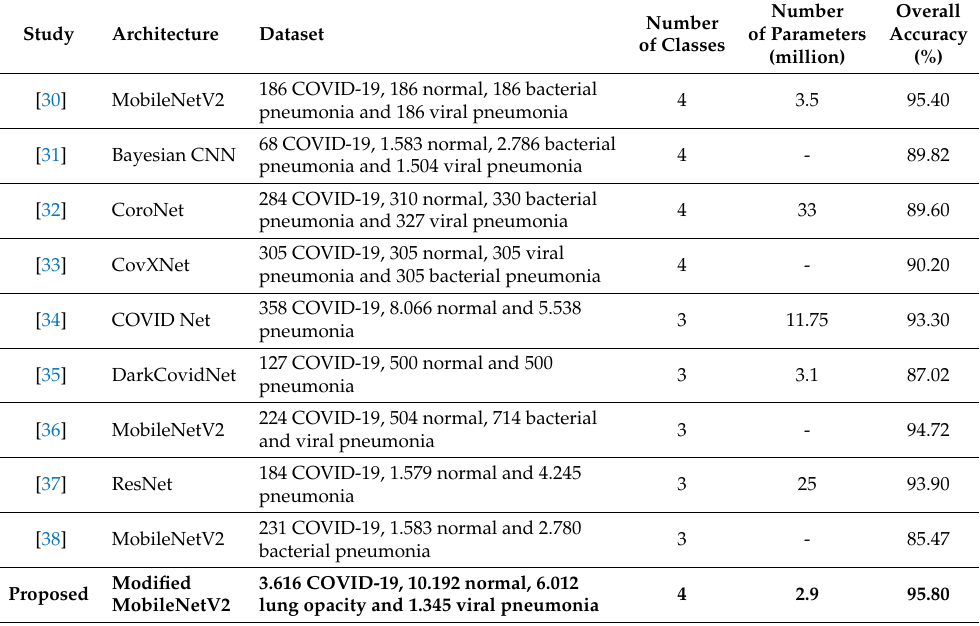
Table 5. Comparison of the proposed model with other existing models for COVID-19 classification using chest X-ray images for 3 or 4 class